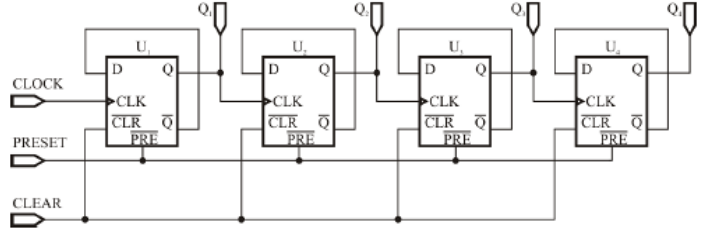
Figure 8. Proposed TPG.